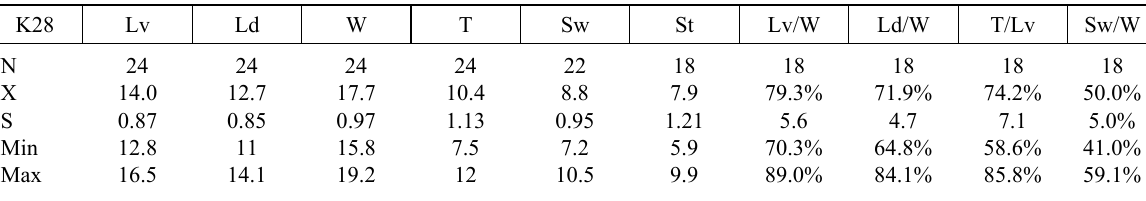
Table 3. Basic statistics of 24 shells of Stegocornu procerum D(cid:252)rkoop, 1970; Llandovery, mid-late Aeronian, Niur Formation,